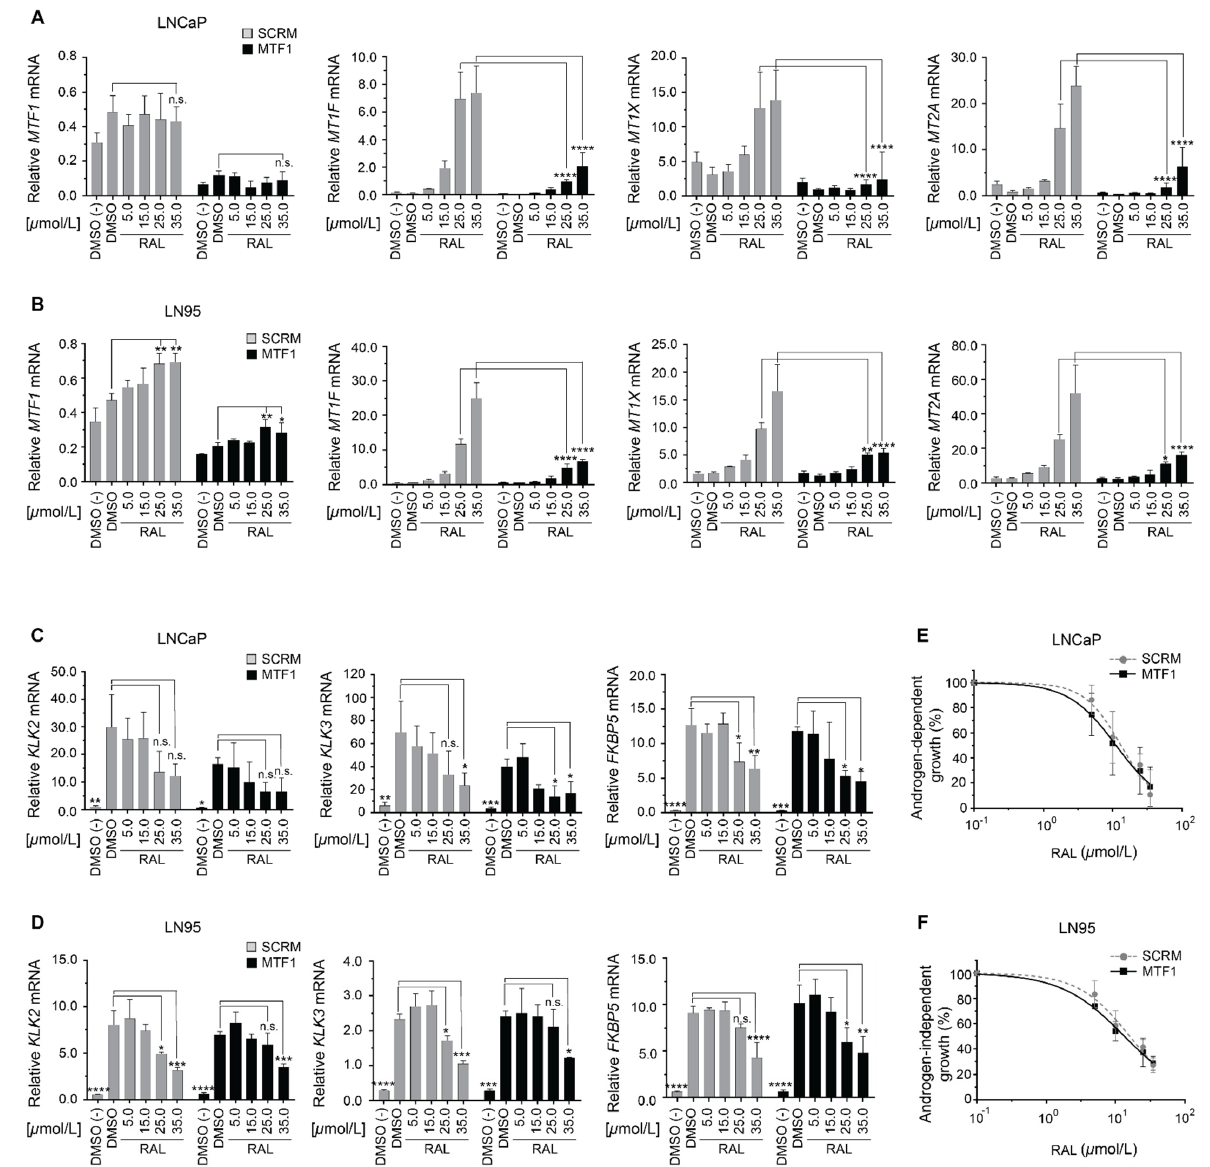
Figure 5. Ralaniten-induced expression of metallothionein is dependent on levels of MTF-1. ( A ) Transcript levels of MTF-1, MT1F, MT1X, and MT2A were normalized to transcript levels of SDHA from LNCaP and ( B ) LN95 cells treated with siRNA targeting MTF-1 followed by incubation with increasing concentrations of ralaniten (5–35 µ M), all in the presence of R1881. DMSO is with R1881. Only DMSO ( − ) was not treated with R1881. ( C ) Transcript levels of KLK2, KLK3, and FKBP5 were normalized to levels of SDHA transcript from LNCaP and ( D ) LN95 cells treated with siRNA targeting MTF-1 with subsequent treatment increasing concentrations of ralaniten (5–35 µ M), all in the presence of R1881. DMSO is with R1881. Only DMSO (-) was not treated with R1881. Data presented as mean ± SD and analyzed by two-way ANOVA with Sidak’s test applied post hoc ( n = 3 independent experiments). ( E ) LNCaP cells were treated with scramble (control) or MTF1 siRNA prior to incubating with 0.1 nM R1881 for 3 days before harvesting and analyzing for proliferation using the crystal violet assay. ( F ) LN95 cells treated with scramble (control) or MTF1 siRNA were incubated in charcoal-stripped serum in the absence of androgen or R1881 for 3 days before harvesting and analyzing cell growth with the crystal violet assay. Data presented as mean ± SD and analyzed by two-way ANOVA with Sidak’s test applied post hoc ( n = 3 independent experiments). * p < 0.05; ** p < 0.01; *** p < 0.001; **** p < 0.0001; n.s., not